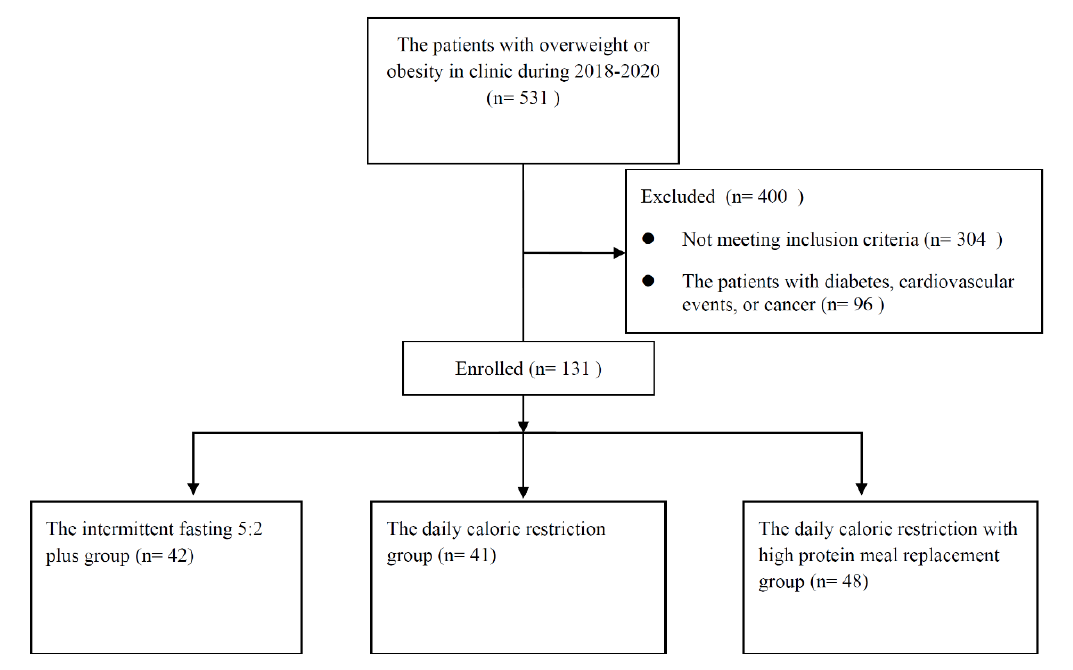
Figure 1. Study Flow Diagram. Table 1. Baseline participant characteristics.